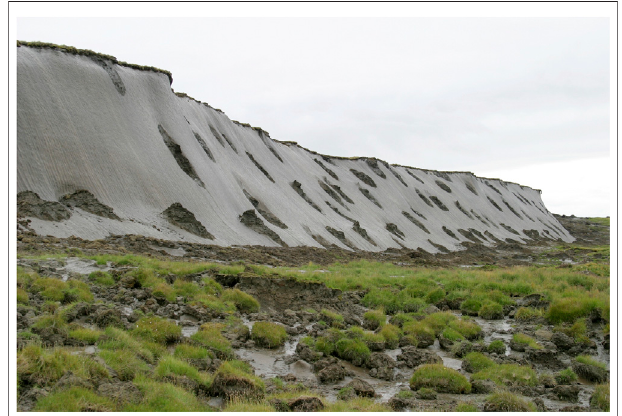
FIGURE 10 | Yedoma Ice Complex deposits on the Kondrat`yeva yedoma coastal bluff. The height of the bluff is 15